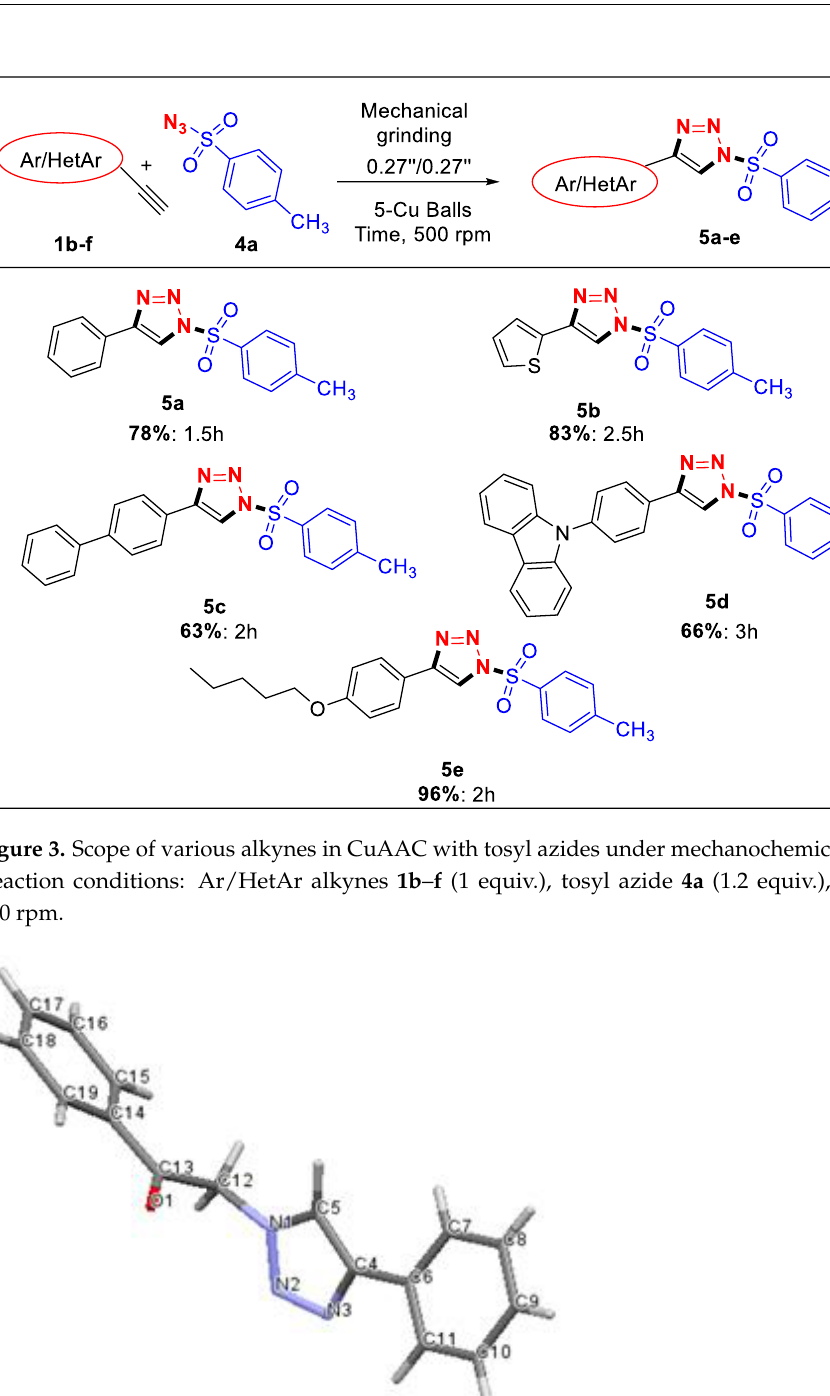
Figure 4. Single crystal XRD structure of 3b . CCDC number for the compound 3b is 2123952.